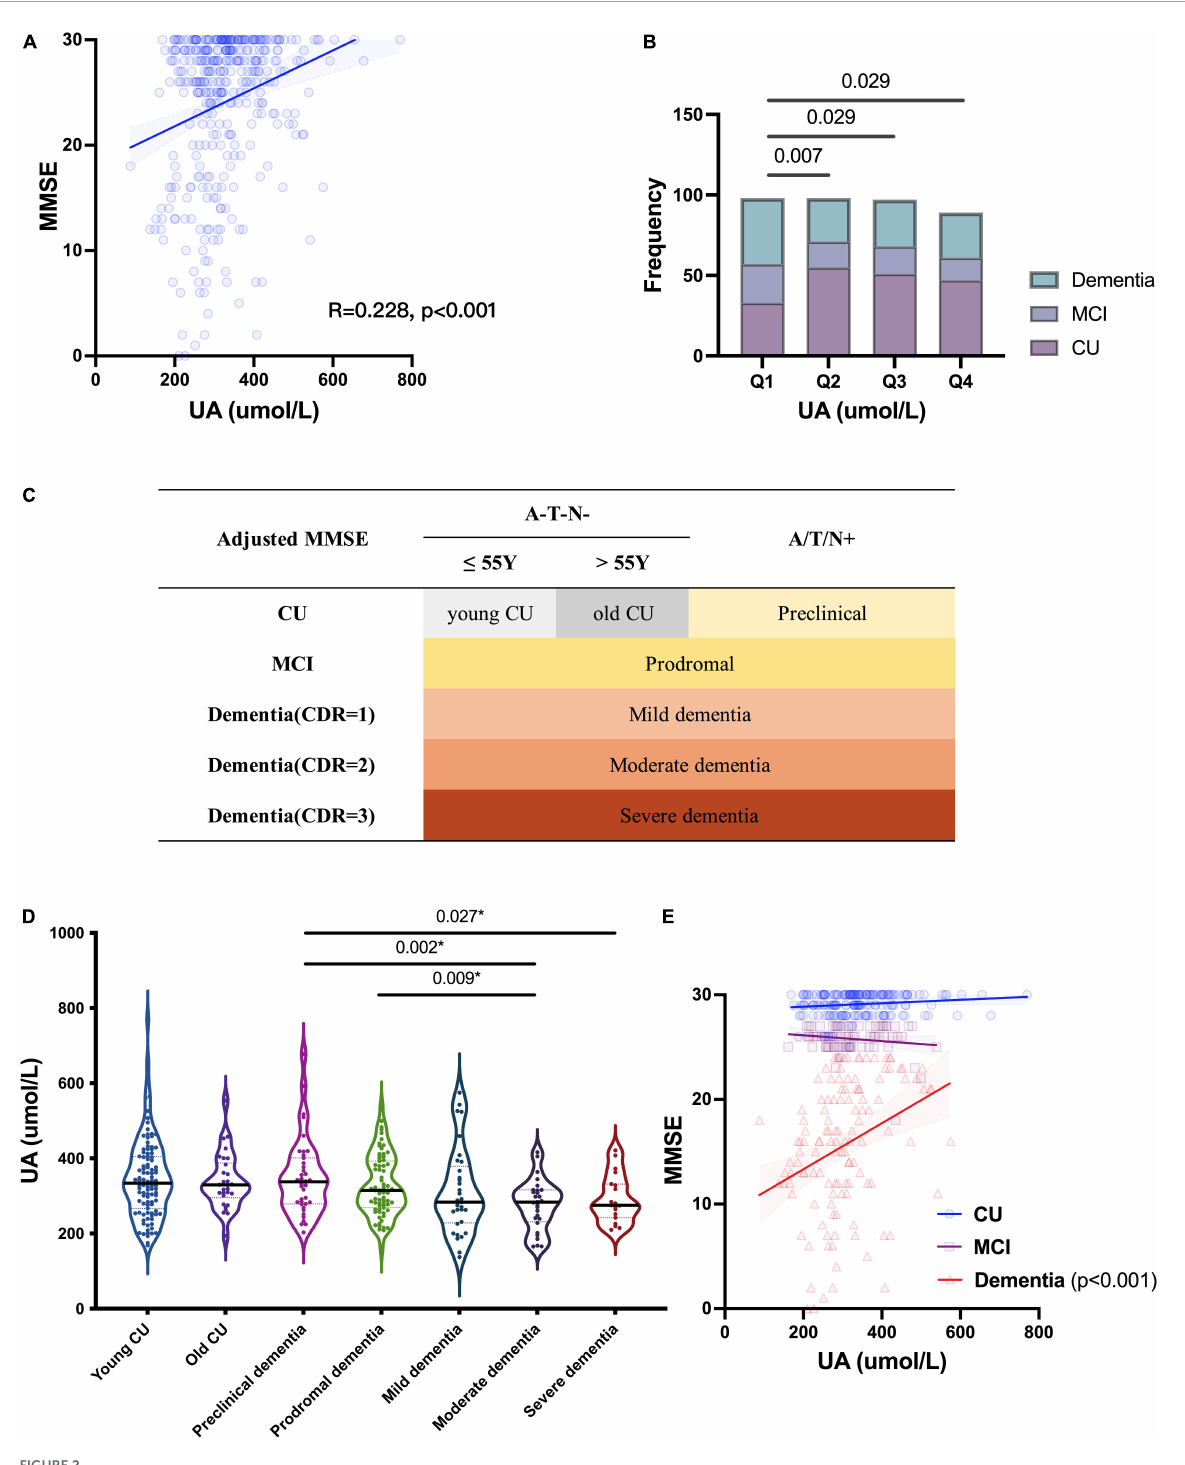
FIGURE2 Relationship of UA and cognitive function. (A) Spearman’s correlation analysis between the levels of sUA and MMSE scores. (B) Proportion of CI phrases in different levels of sUA (Q1 - Q4: the levels of sUA were stratified into 4 subgroups from the lowest to the highest levels as quartiles 1–4). (C) Staging as MMSE, CDR and cut-offs of ATN biomarkers; A/T/N + means positive on at least one ATN biomarkers. (D) Kruskal–Wallis test for the levels of sUA among the different cognitive stages. The p value, two-tailed Mann–Whitney U test between two subgroups; (E) Spearman’s correlation analysis between the levels of sUA and MMSE scores in the stages CU, MCI and dementia. The p value, two-tailed chi-squared